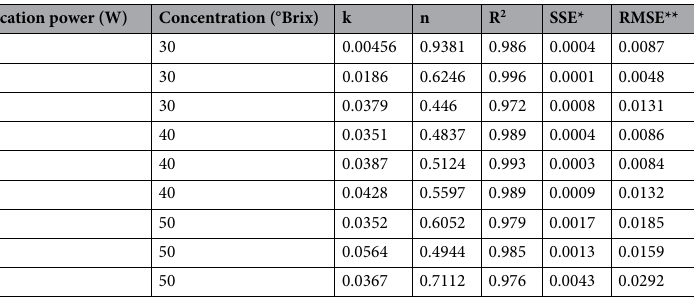
Table 1. Parameters of Page model describing the kinetics of osmotic dehydration rate of apples slices. *The sum of squares due to error (SSE). **Root mean squared error (RMSE).